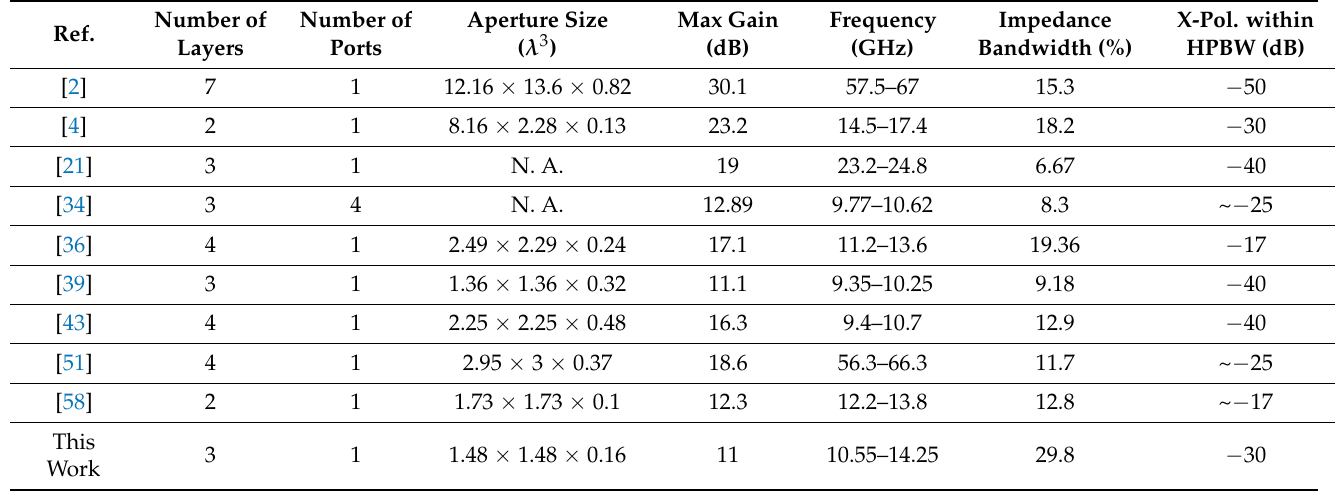
Table 1. Comparison between previously reported antennas and the proposed